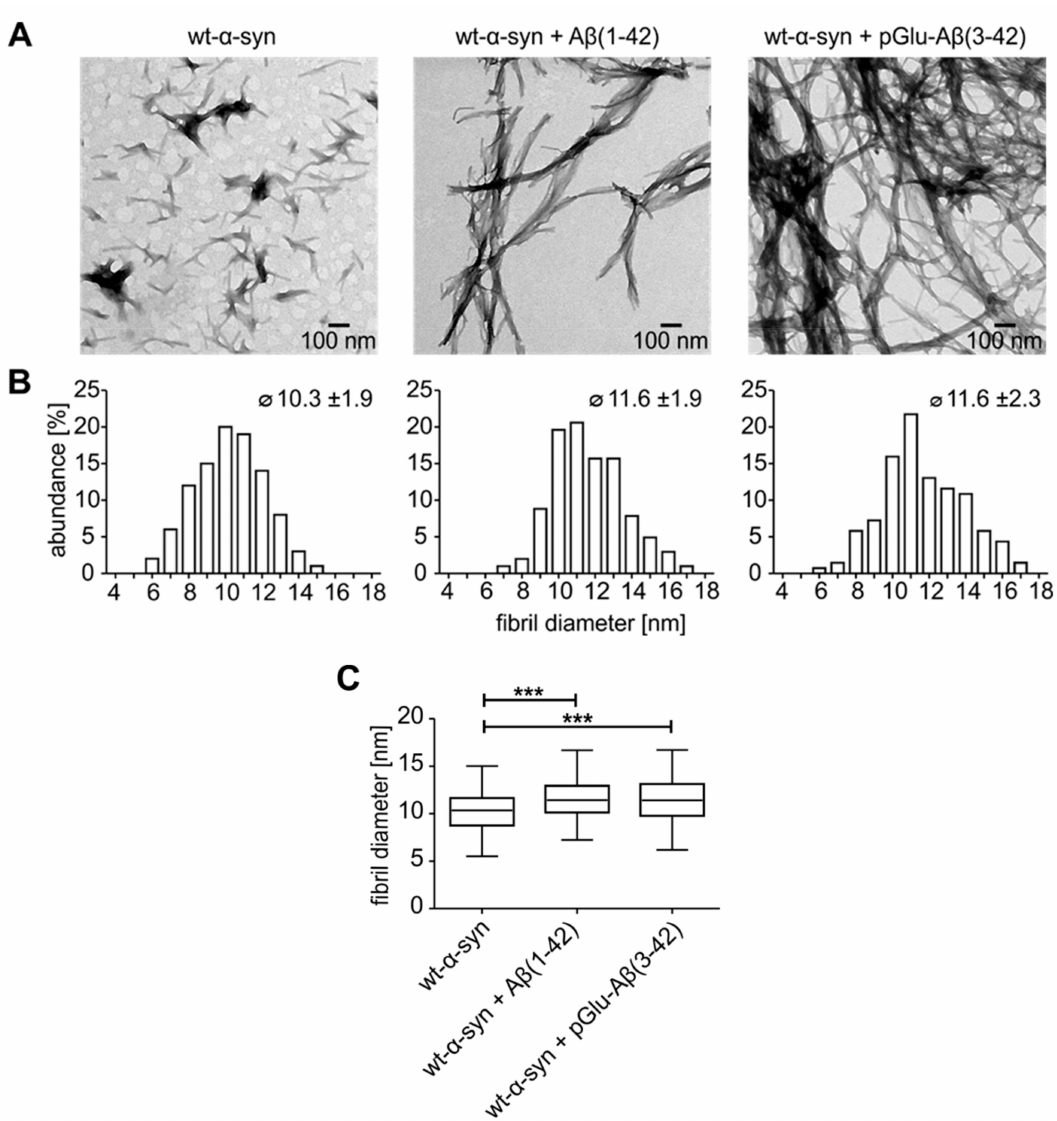
Figure 5. Analysis of amyloid fibrils formed from wt- α -synuclein (75 µ M) alone or in the presence of A β (1–42) or pGlu-A β (3–42) (1 µ M). ( A ) Negative stained TEM images and ( B ) corresponding histograms, mean value and standard deviation of fibril diameter quantifications from the above TEM images ( n = 100). ( C ) Corresponding statistics of fibril diameter (mean ± SD, n = 100, *** p ≤ 0.001, one-way ANOVA followed by Tukey post-hoc